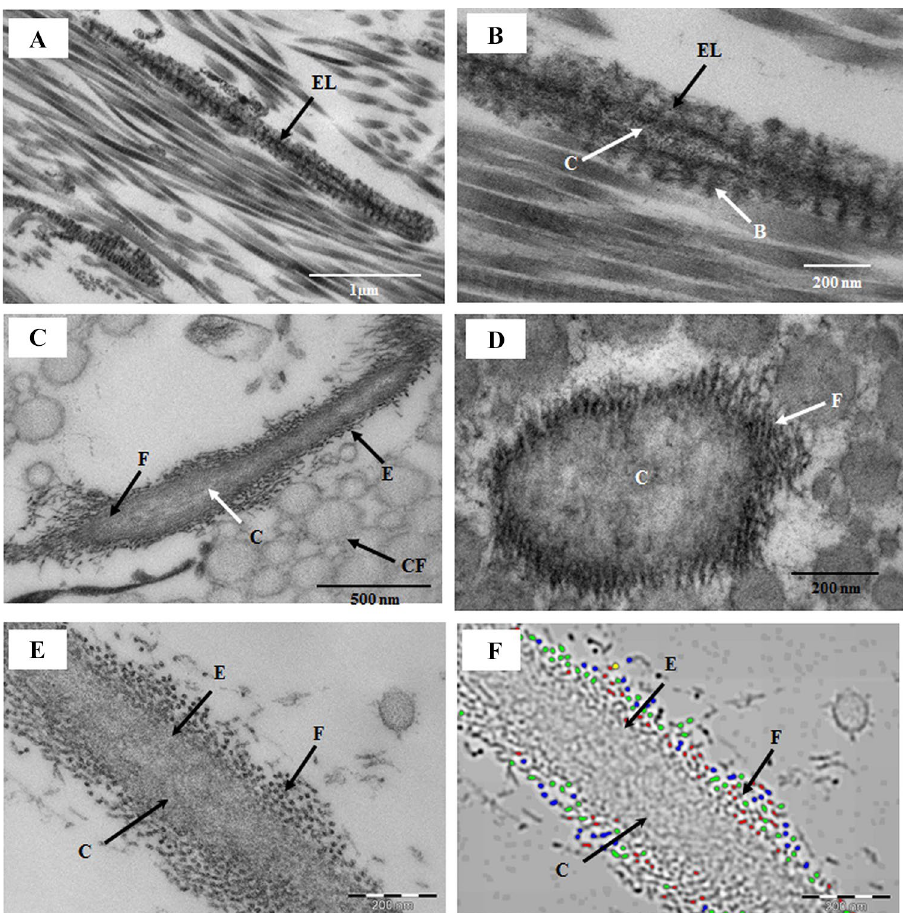
Figure 4. Electron micrographs of the fibers of the sclera. ( A , B ) Part of the sclera showing a longitudinally running elastic-like fiber (EL) containing a central elastic core (C) and thick electron-dense bands (B), which are connected by thin microfibrils. These fibers are similar to EL fibers reported by Rohen et al. 20 ( C ) Longitudinally running typical elastic fibers containing a homogenous central core, surrounded by thin microfibrils (6.78 ± 2.70 nm). ( D ) Cross-section of the elastic fibers showing a central core surrounded by thin fibrils. ( E ) Part of elastic fibers containing an elastic core and cross-section of microfibrils. ( F ) Digital image of thin fibrils (6.79 ± 2.70 nm) around the elastic core of the elastic fiber. EL elastic-like fibers (Rohen et al., 1981), E elastic fiber, F fibrils (6.79 ± 2.70 nm), C elastic core, B electron-dense bands; CF collagen